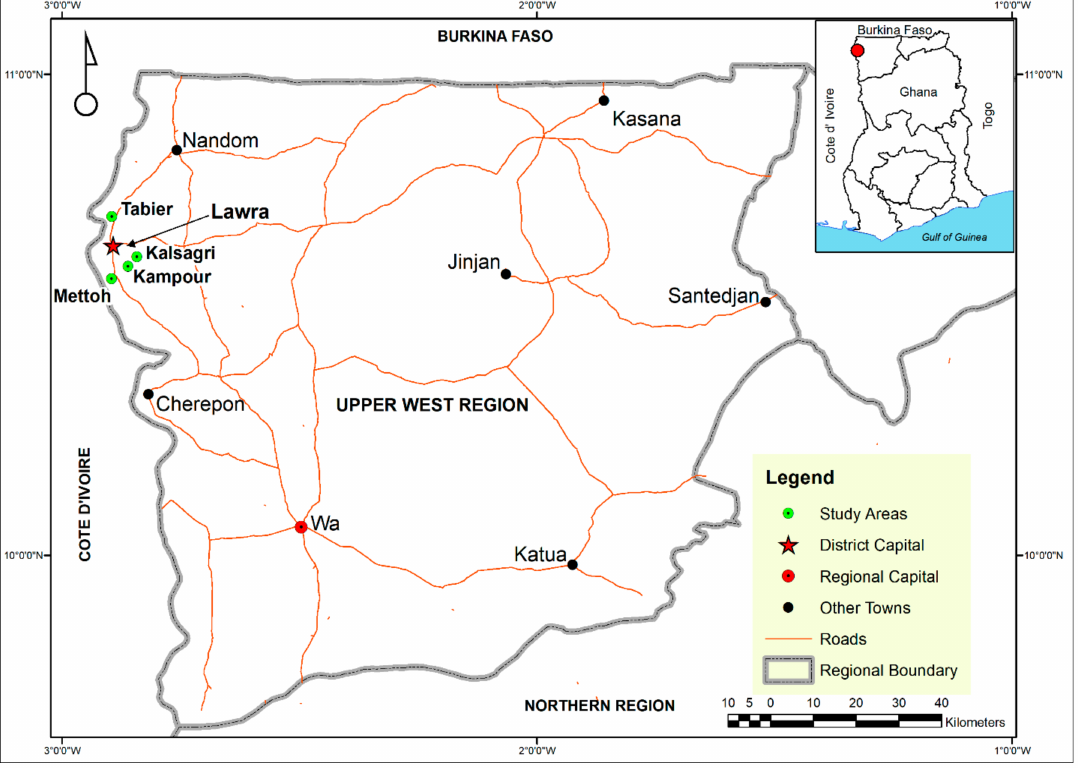
Figure 1. Map of the Study